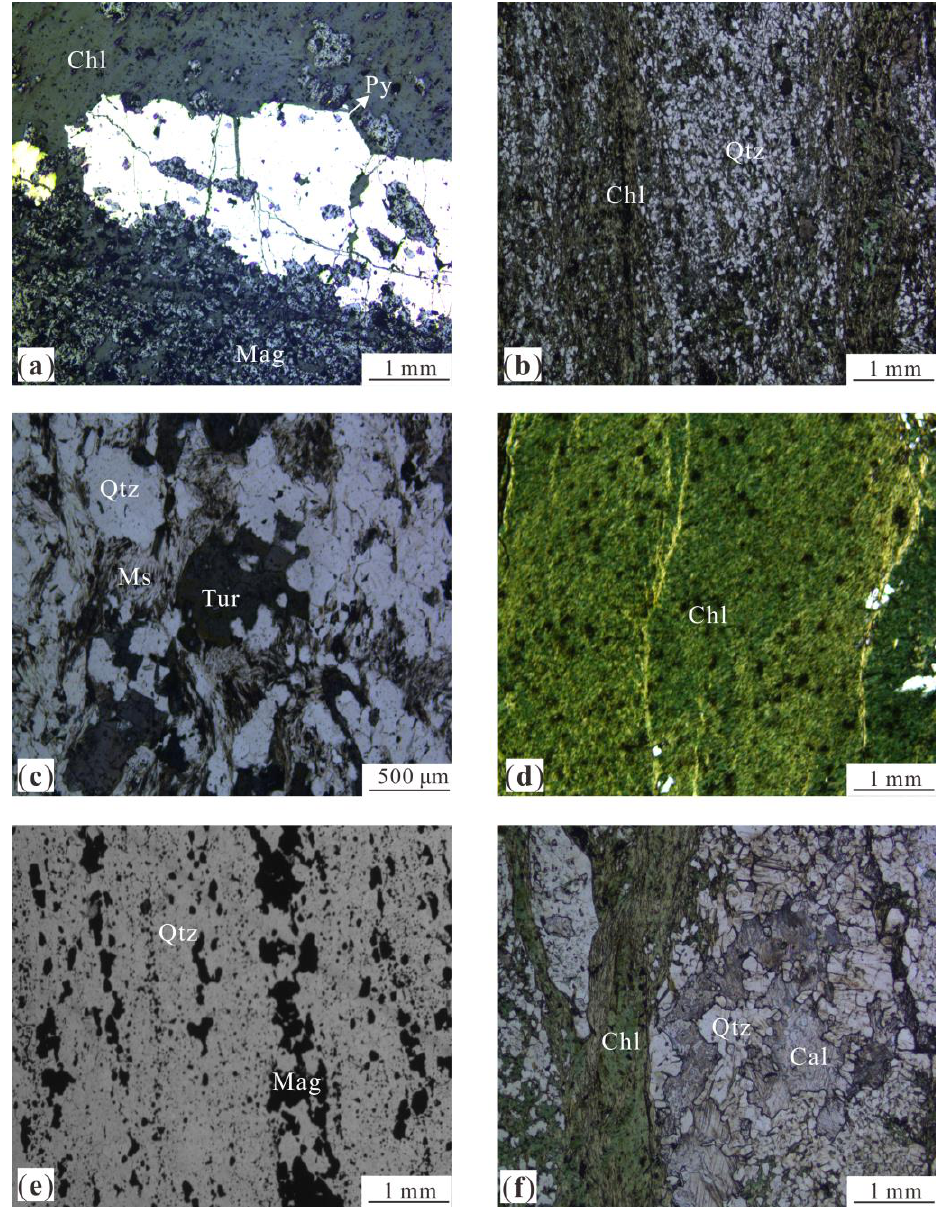
Figure 16. Photomicrographs of the samples (plane-polarized light): ( a ) the photomicrograph of Q-2; ( b ) the photomicrograph of Q-4; ( c ) the photomicrograph of Q-9; ( d ) the photomicrograph of Q-11; ( e ) the photomicrograph of Q-12; ( f ) the photomicrograph of Q-13.